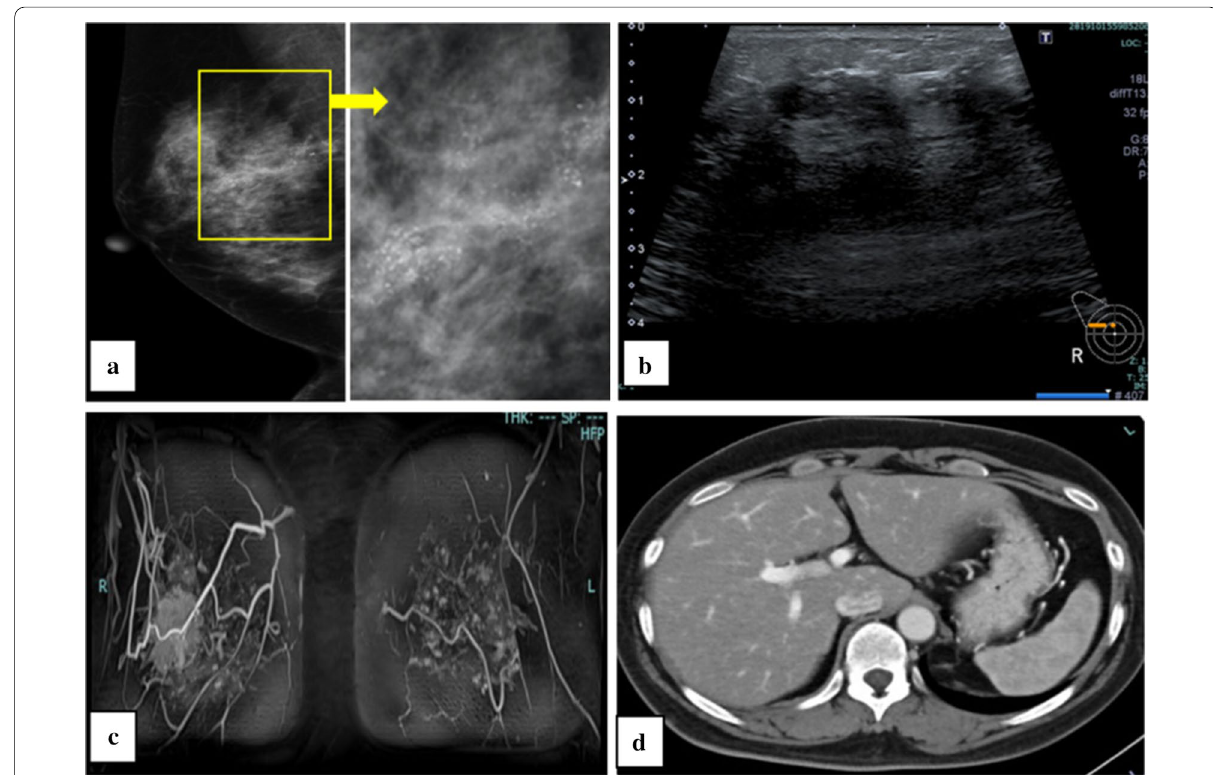
Fig. 1 Imaging findings. a Mammogram shows segmental polymorphic calcifications (yellow square) in the right ML-UM (BI-RADS 5). b Ultrasound revealed an axial 45 mm hypoechoic mass with internal coarse calcifications in the right breast (BI-RADS 5). c Contrast magnetic resonance imaging showed wide-range non-mass enhancement in the upper-outer quadrant of the right breast. d Contrast computed tomography showed that there was no distant metastasis and liver morphology was maintained and no gallstones were